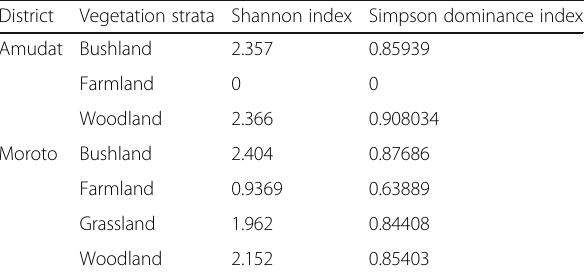
Table 3 Diversity of wood species among the land cover types District Vegetation strata Shannon index Simpson dominance index